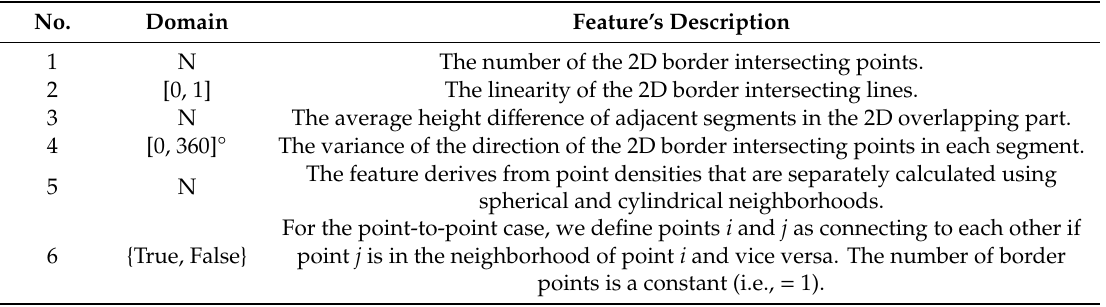
Table 3. Heuristic rule-based features description.